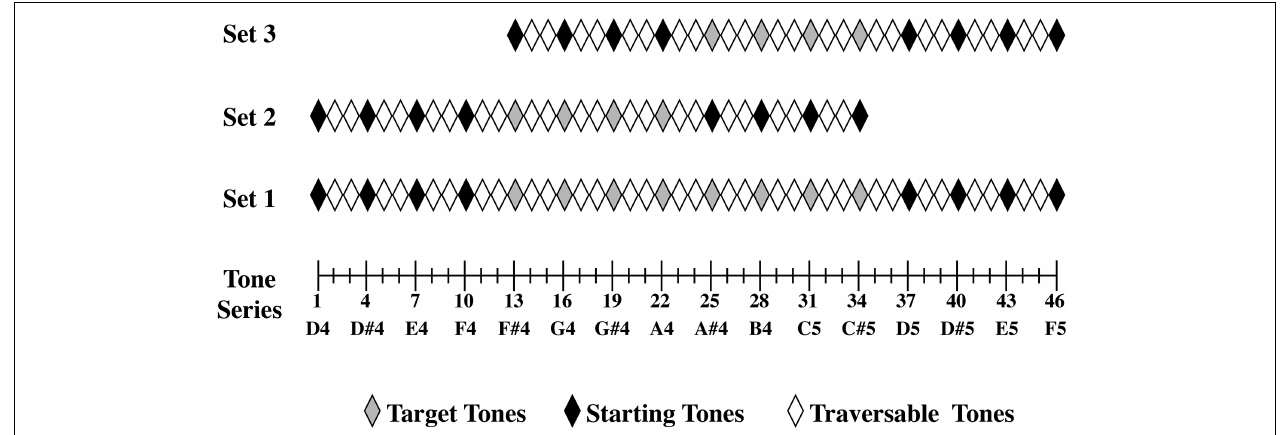
FIGURE 2 | Three sets of tones (or distributions of tones) were constructed from the original pure tone series that ranged from [D4] to [F5]. Set 1 consisted of stimuli 1–46 from our pure tone series, set 2 consisted of stimuli 1–34 from our pure tone series, and set 3 consisted of stimuli 13–46 from our pure tone series. In set 1, stimuli 1, 4, 7, 10, 37, 40, 43,